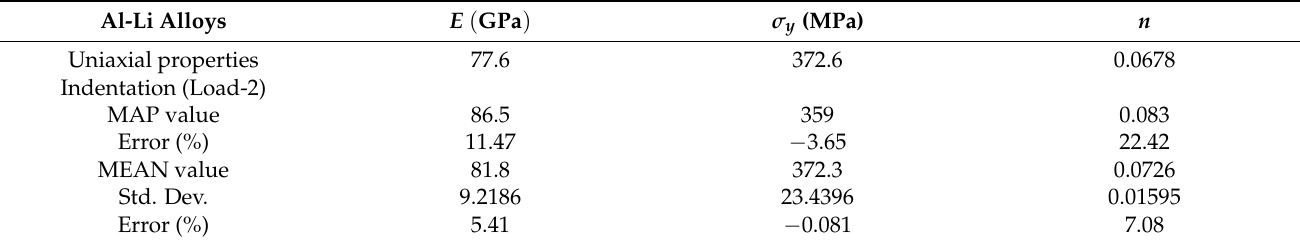
Table 3. Comparison of the identified MAP, MEAN values of elastoplastic properties using the imprint snapshot under indentation